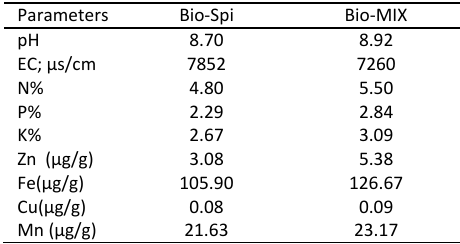
Table3. Composition of cyanobacteria – OMW biofertilizers Table 3. Composition of cyanobacteria – OMW